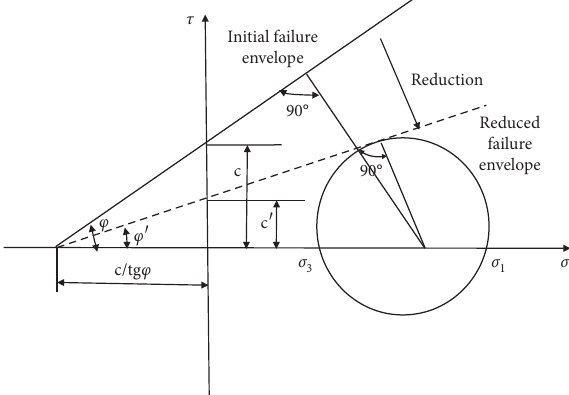
Figure 1: Calculation principle of